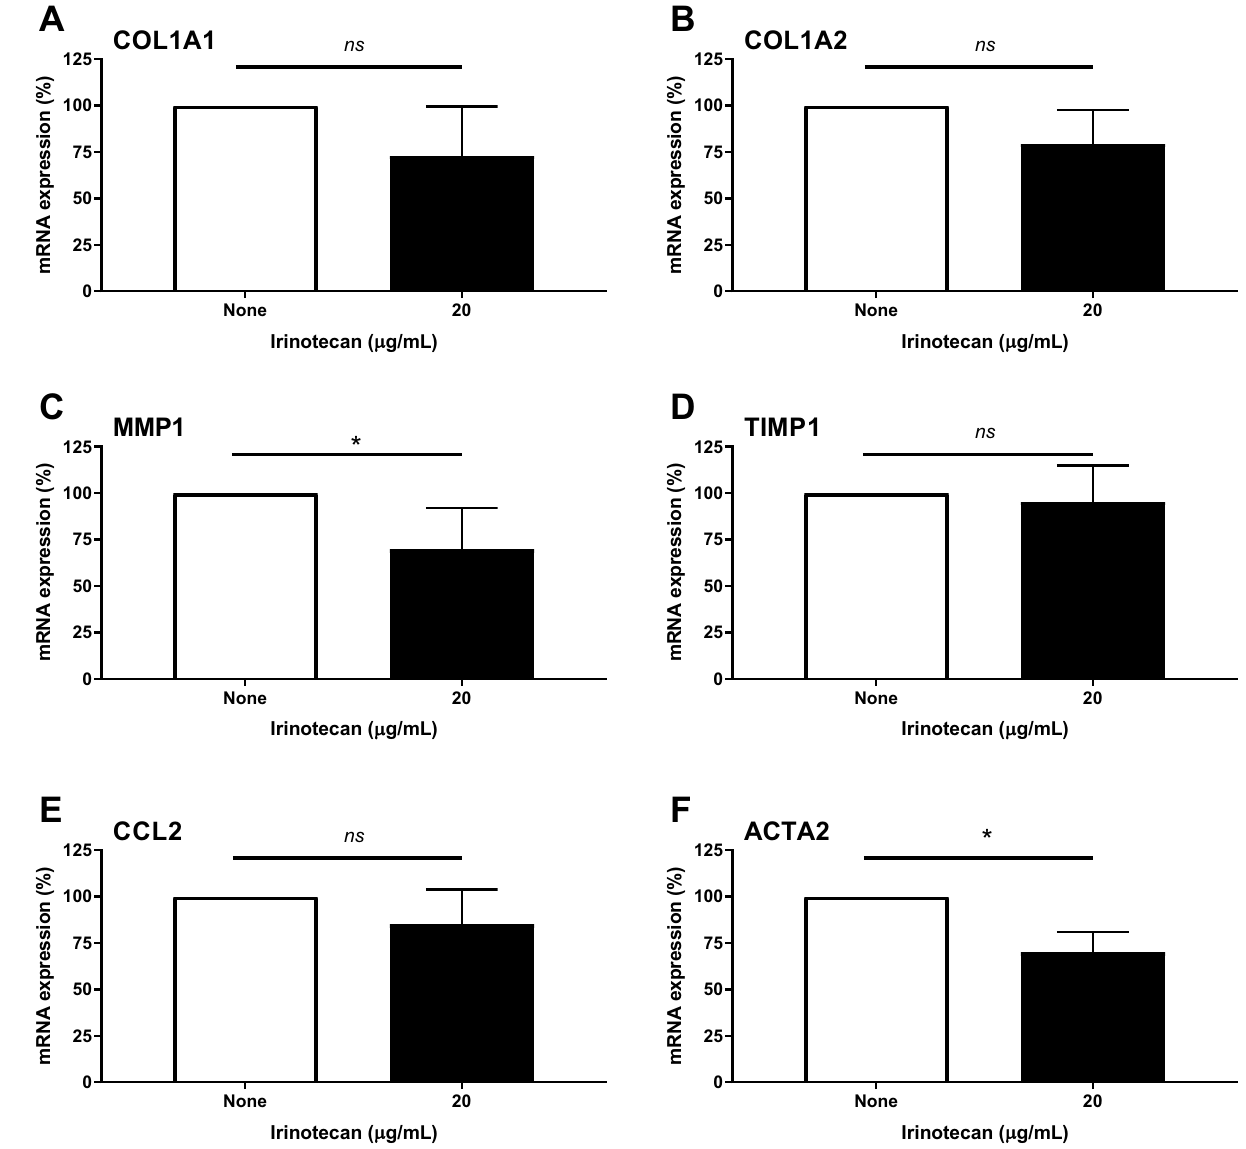
Figure 3. Analysis of irinotecan effect on mRNA expression of genes involved in fibrosis in dermal SSc fibroblasts. Relative mRNA expression of a panel of genes involved in fibrosis (from A to F: COL1A1, COL1A2, MMP1, TIMP1, CCL2 and ACTA2) in dermal fibroblasts obtained from 4 systemic sclerosis patients treated with irinotecan (20 µg/mL), in comparison to a non-treated condition. The non-treated condition